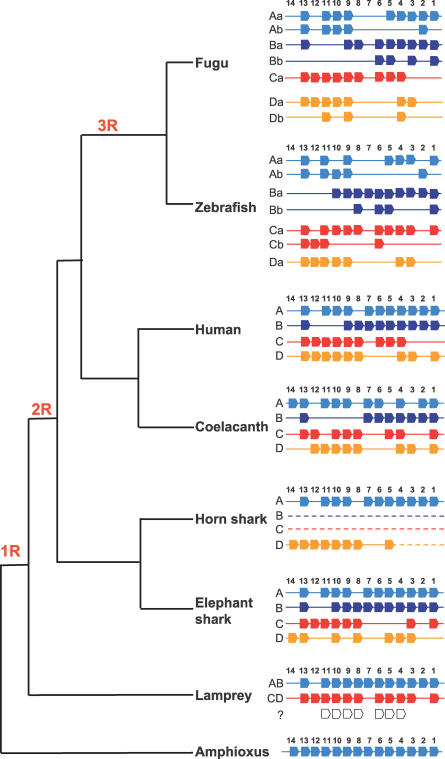
The Evolution of Vertebrate Hox Cluster Organization and the History of Whole-Genome Duplications in VertebratesThe additional Hox genes in the lamprey (shown as white arrows) are the result of a lineage-specific duplication of the “AB” or “CD” Hox cluster. In the horn shark, only a partial HoxD cluster (from HoxD5 to HoxD14) has been sequenced, and HoxB and HoxC clusters are yet to be sequenced. The number of Hox clusters in various lineages is consistent with one round of genome duplication (“1R”) during the evolution of jawless vertebrates from chordate invertebrates, a second round (“2R”) before the emergence of jawed vertebrates but after the divergence of the lamprey lineage, and a third round (“3R”) in the ray-finned fish lineage before the divergence of zebrafish and fugu lineages. See text for the source of Hox cluster information.